Question: Briefly state, in one sentence, what is plotted here.
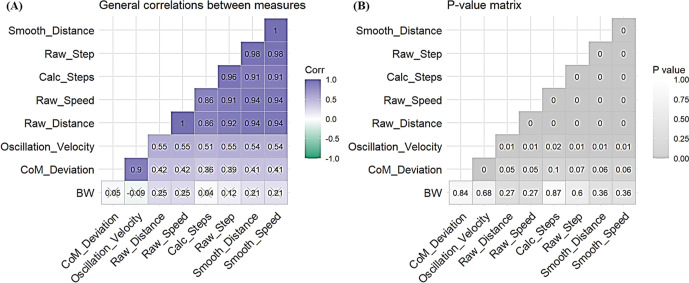
Answer: (A) Correlation matrix between the raw and calculated values derived from smoothing zigzag trajectories resulting from oscillatory broiler gait during an open field test (n = 22) and broiler bodyweight. Purple shading indicates positive correlations, while green shading indicates negative correlations. An ‘X’ within a cell indicates non-significant correlations. (B) Corresponding P -value matrix for the correlations shown in panel A; a 0 value indicates a P < 0.001. Figure 3 long description.